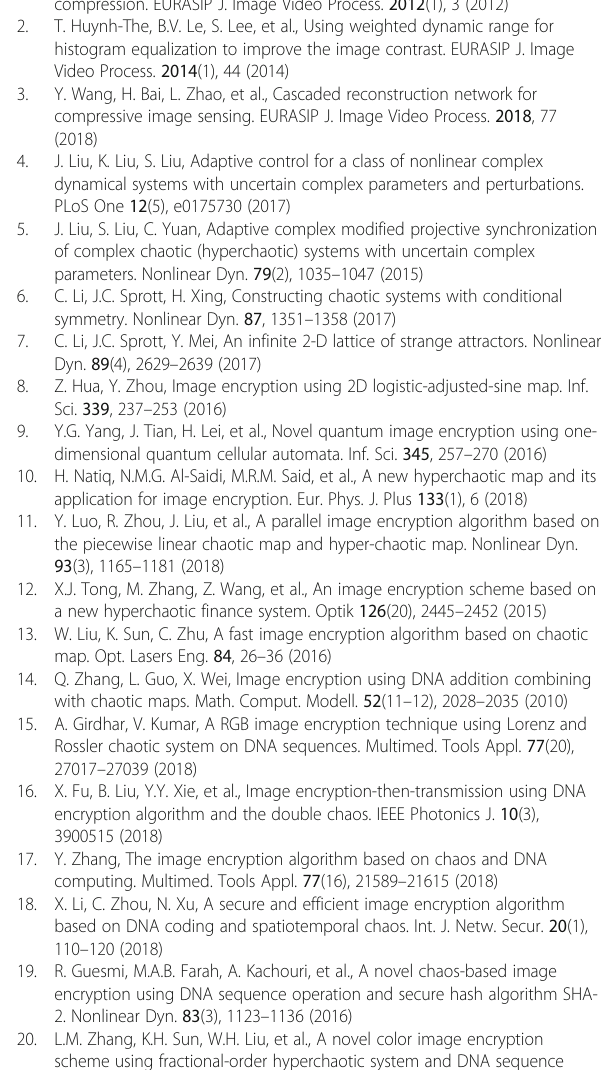
algorithm based on the fractional-order 4D hyperchaotic memristive system can effectively encrypt images and has more efficiency, which provides the related theoretical basis and practical application foundation applied to cryptography, secure communication and information se- curity and other